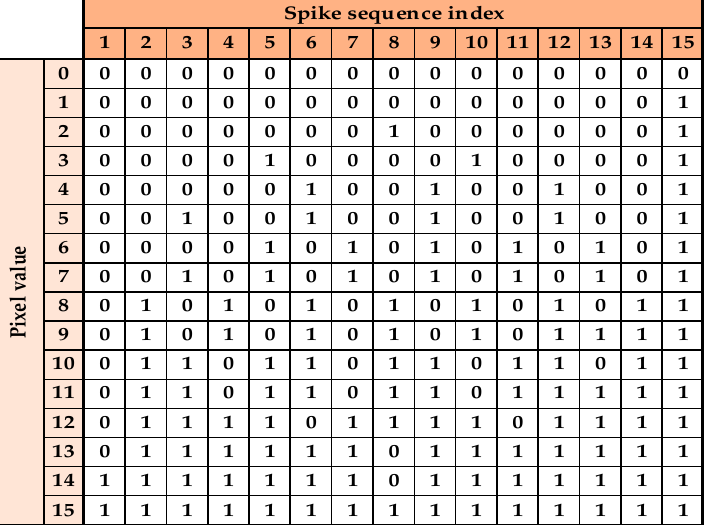
Figure 3. 4–bit pixels, Binary Streamed Rate Coding (BSRC) conversion results.